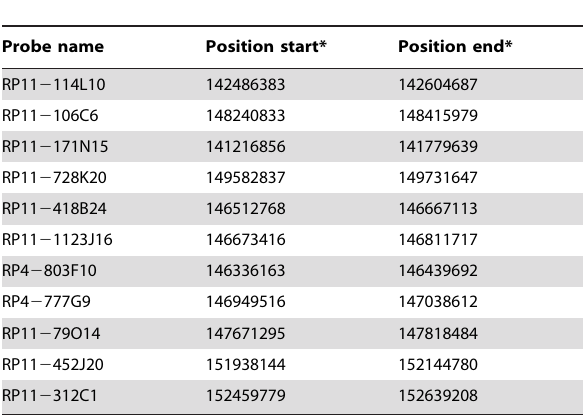
Table 2. Name and position of FISH